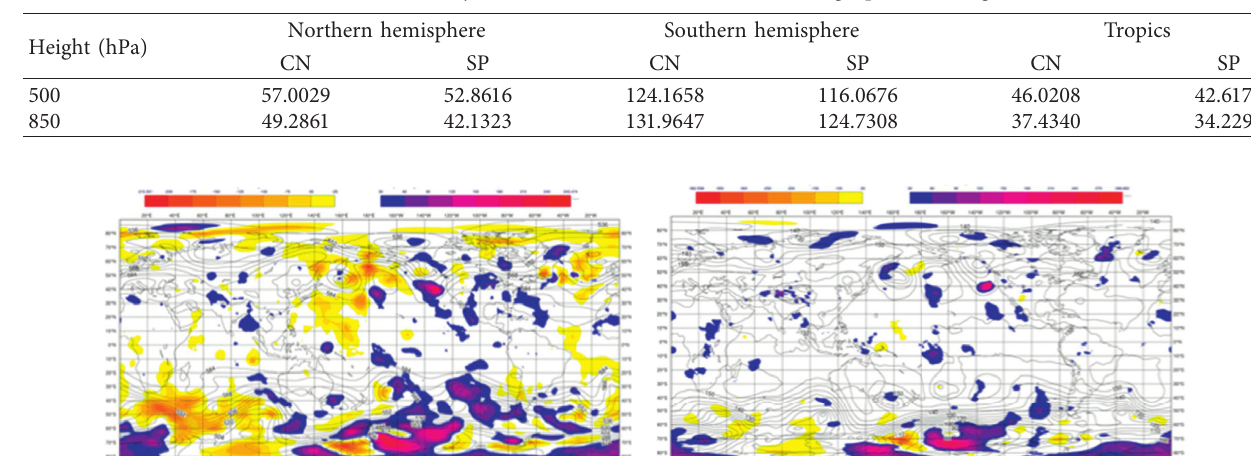
Table 1: The monthly mean RMSE for 500hPa and 850hPa geopotential heights.